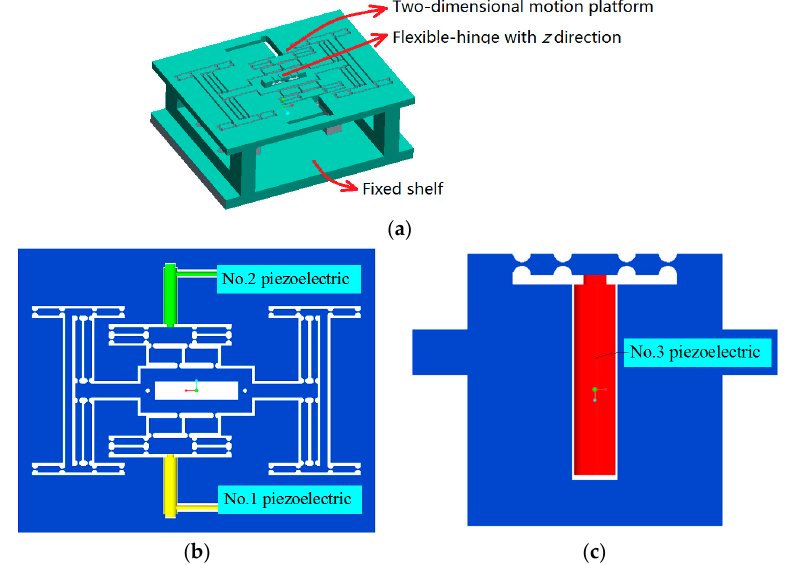
Figure 1. Schematic of a three degrees of freedom (3-DOF) motion device. ( a ) Overall design of the system; ( b ) two-dimensional (2D) motion platform ( x and y directions); ( c ) flexible-hinge with z direction. z